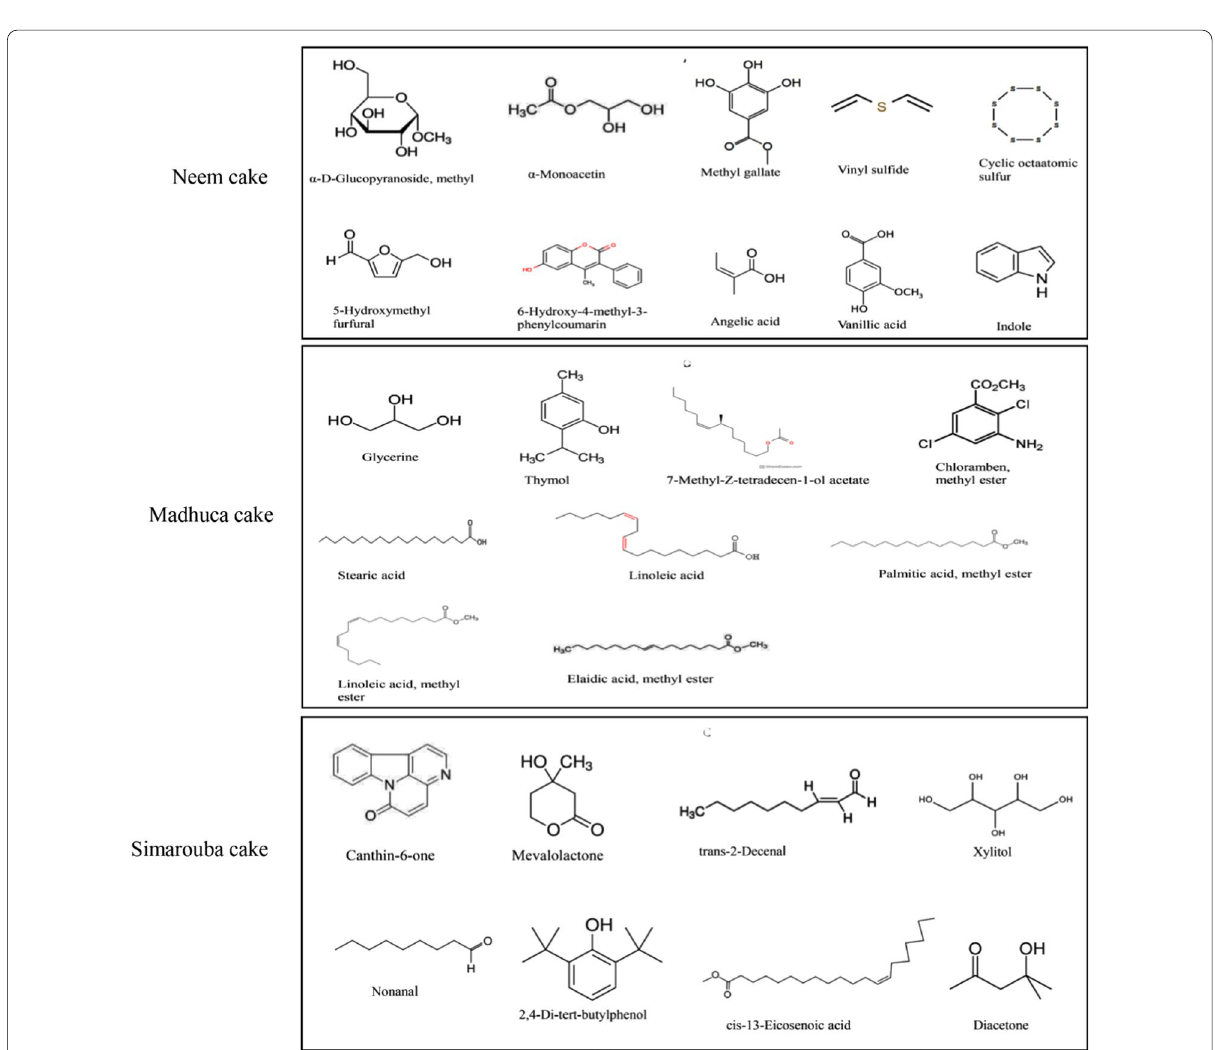
Fig. 5 Structure of some pharmaceutically active phytochemicals of non-edible oil-seed cakes of neem, madhuca, and